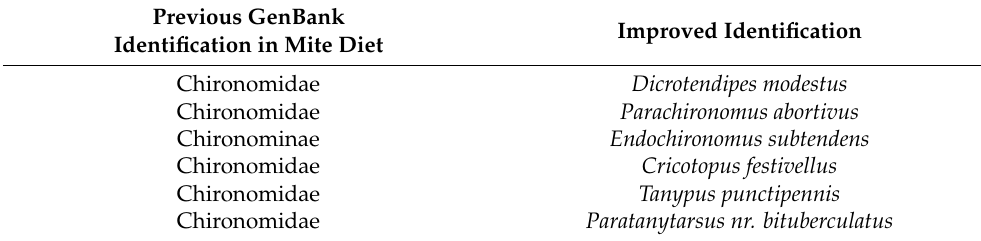
Figure 5. Summary of numbers of members of the curated chironomid database that either confirmed the identity of mite diet sequences or improved them from family to either genus or species or from genus to species. Table 1. Summary of family to species improvements.